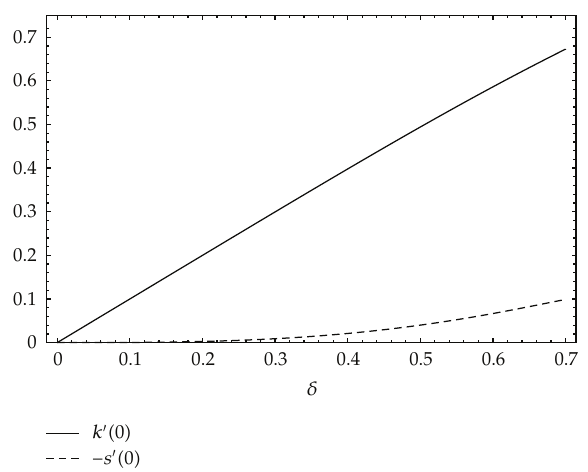
Figure 5: The normalized shear on the disk in the x (cid:3) k (cid:2) (cid:3) 0 (cid:4)(cid:4) and y (cid:3) s (cid:2) (cid:3) 0 (cid:4)(cid:4) directions, obtained by the 8th-order approximation of the